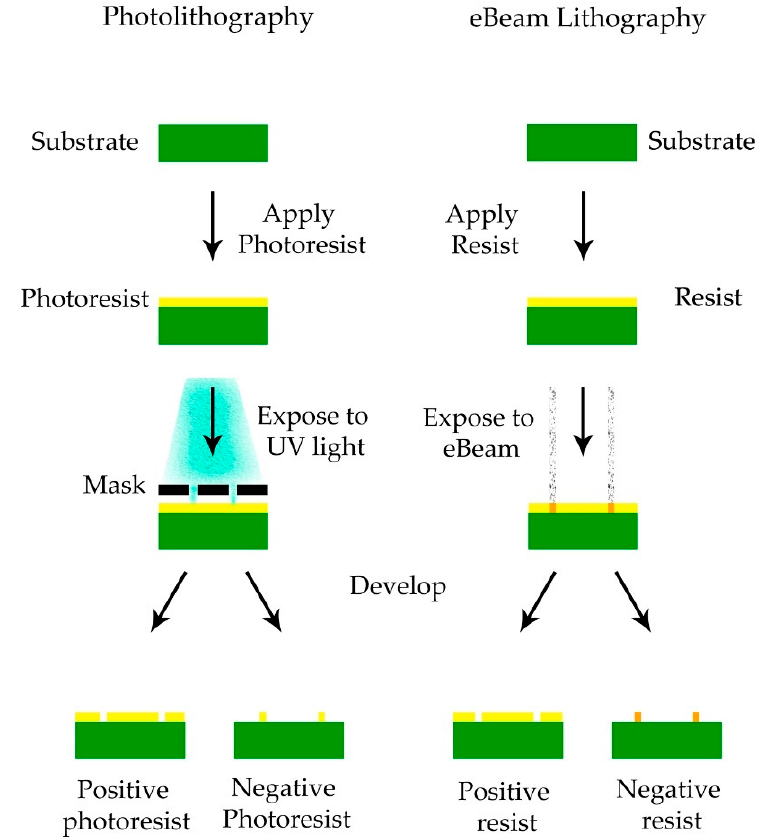
Figure 3. From left to right: photolithography and electron beam lithography.